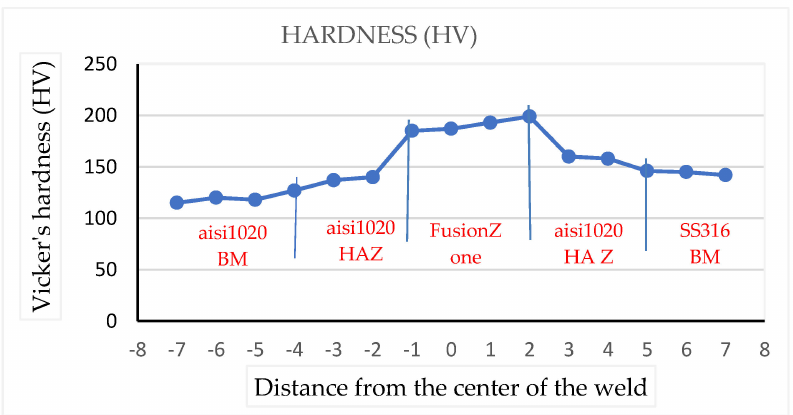
Figure 18. Vickers hardness of sample no.